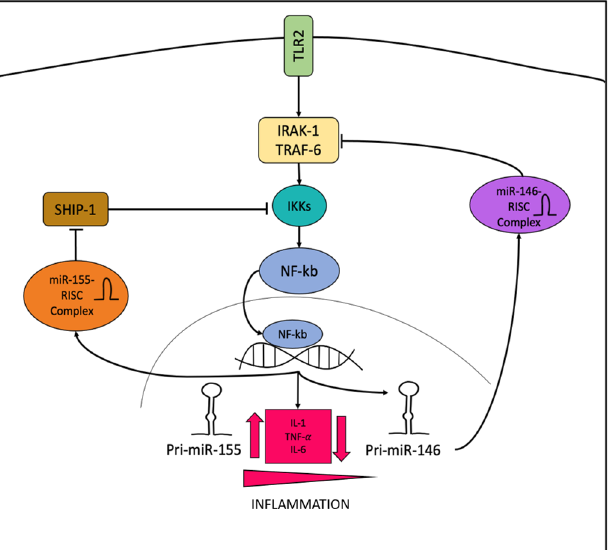
Figure 1. The TLR2/NF-kb pathway: NF-kb, after the activation of TLR2 receptor induces pro- inflammatory cytokines. In addition, it also induces miR-155 which positively promotes the pathway leading to an amplification of the pro-inflammatory signal. On the other hand, miR-146, whose expression is induced later, negatively regulates this pathway, inhibiting IRAK-1/TRAF-6.